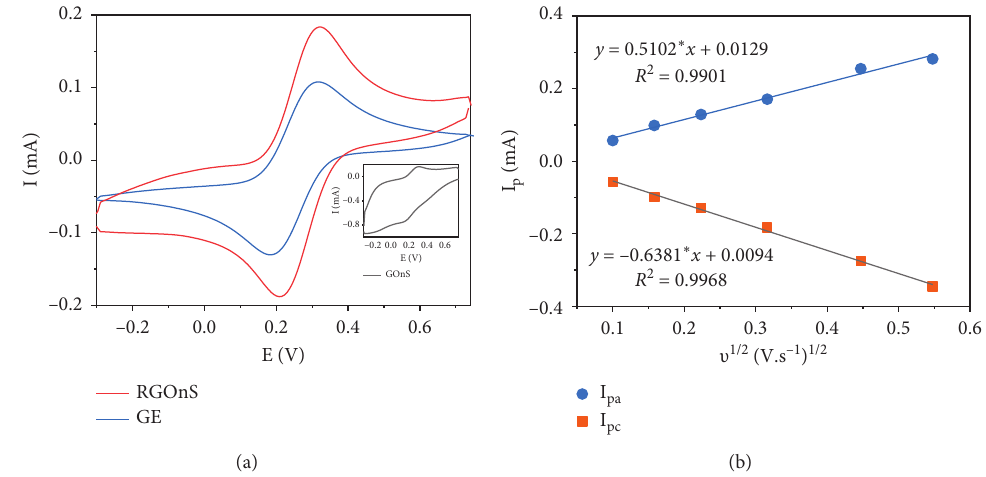
Figure 3: Cyclic voltammograms of graphite, reduced graphite oxide nanosheet electrodes, and graphite oxide nanosheet (inset) in 0.1M PBS (pH 7.0) containing 5mM K 3 [Fe(CN) 6 ] at v � 100mV/s (a) and the dependence of cathode and anode peak currents (I pa and I pc ) on the square root of scan rate on RGOnS (b).